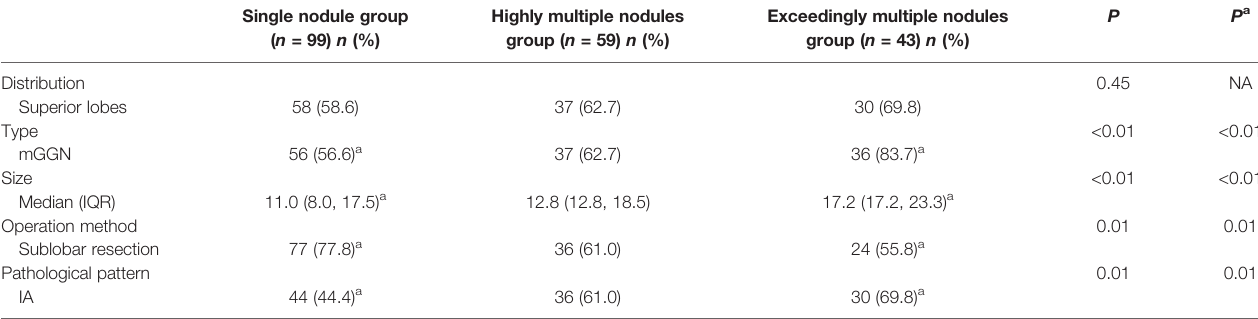
TABLE 3 | Analysis of the characteristics of primary nodules.